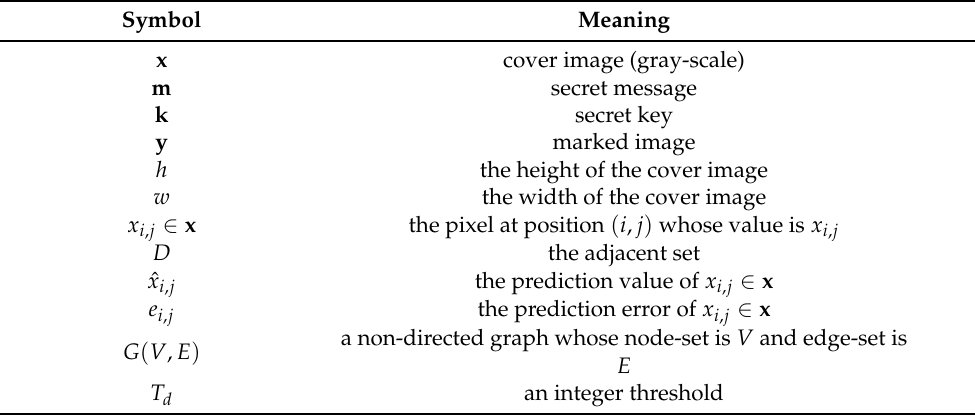
Table 1. Important symbols and their